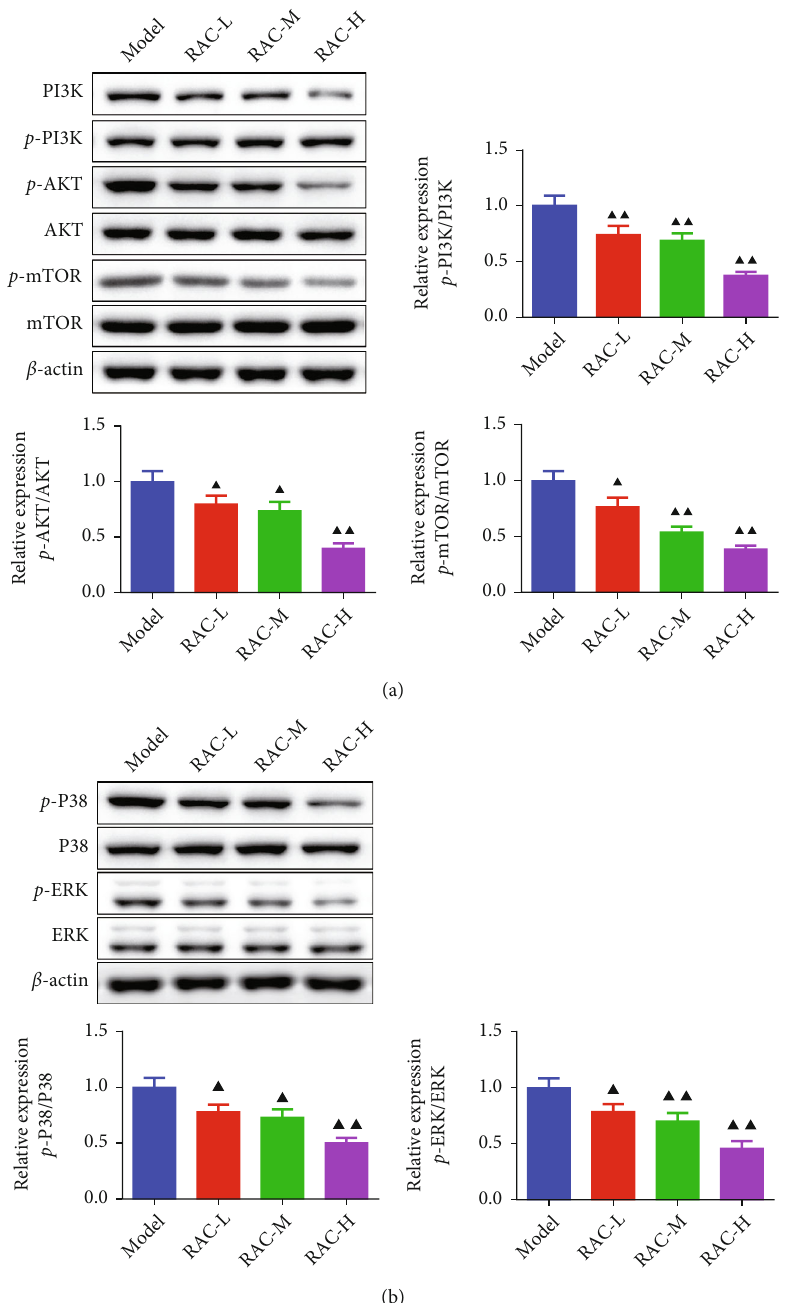
Figure 8: RAC prevented the activation of the PI3K/AKT/mTOR and MAPK pathway. The phosphorylation of PI3K, AKT, and mTOR (a) and P38 and ERK (b) was measured by western blot. ▲ P < 0 : 05 and ▲▲ P < 0 : 01 vs. the model. Results were presented as mean ± SD . n = 3 . Note: RAC: Radix Actinidia chinensis; RCC: renal cell